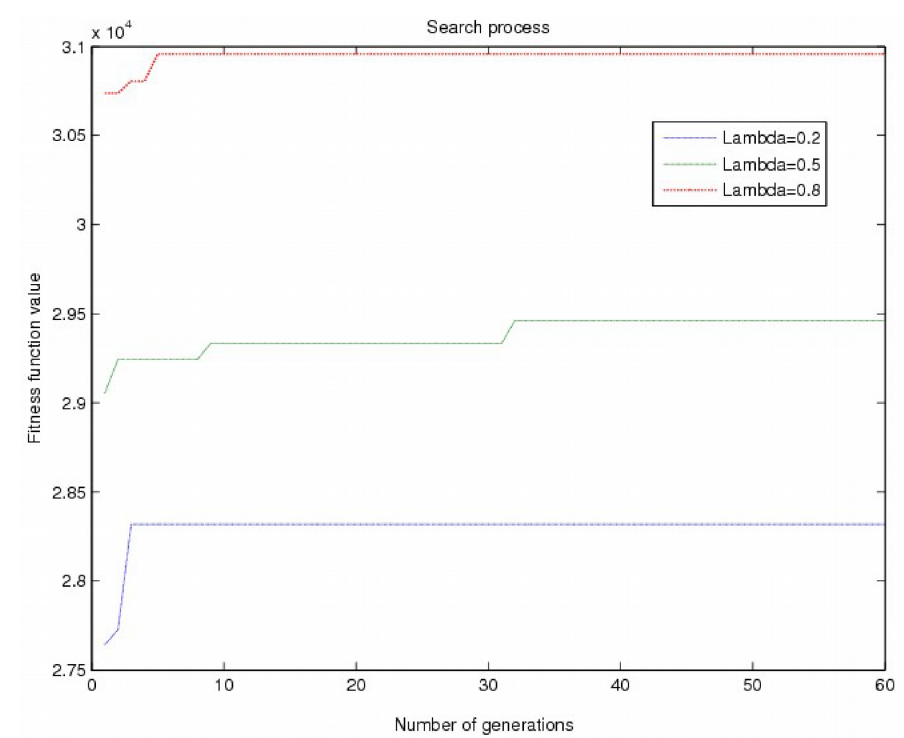
Figure 3. Solution comparison with different values of lambda ( λ